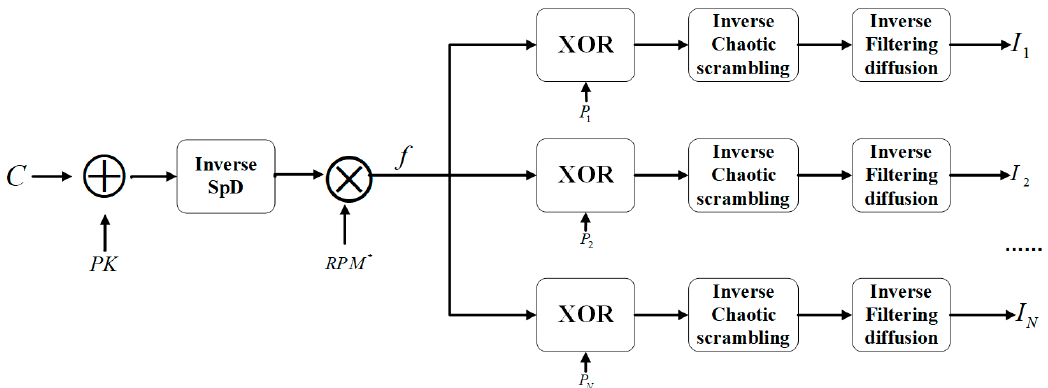
Figure 4. Process of decryption.